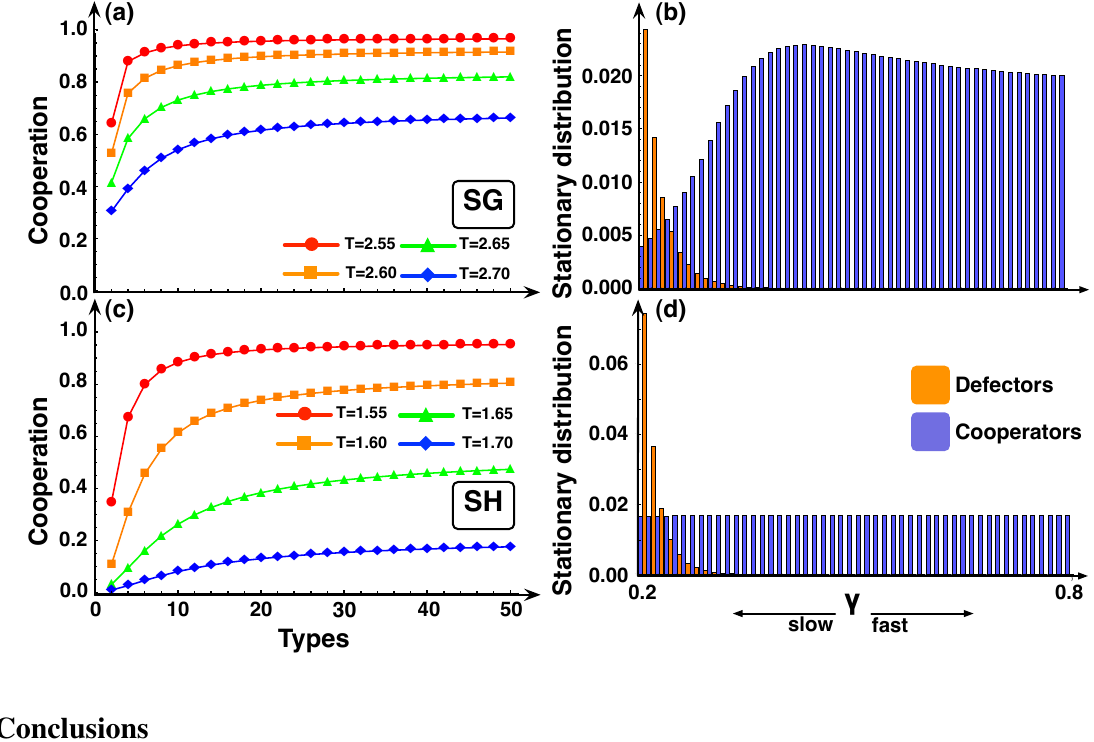
Figure 10. Impact of behavioral differences on cooperation in the snowdrift (upper panels) and stag-hunt (lower panels) games. The plots on the left depict the fraction of time the population spends in a cooperative state (of any type) as a function of the number of types M in the population. Each line corresponds to a different value of the temptation to defect T ( R = 2 , P = 1 , S = 4 − T for the SG and S = 2 − T for the SH). Irrespective of T , cooperation increases with increasing number of types. The bar plots on the right ( T = 2 . 65 and S = 1 . 35 for the SG and T = 1 . 65 , S = 0 . 35 for the SH game), depict the fraction of time that each type of individual is present in a population with 50 different types. While all types of C’s survive, only the slower types of D’s remain in the population. However, the surviving D’s exhibit heterogeneity. As faster D’s manage to survive, part of the strategy flow is diverted into fast C’s ( N = 100 , β = 0 . 01 , M = 50 , c = 0 . 16 and δ = 0 . 3